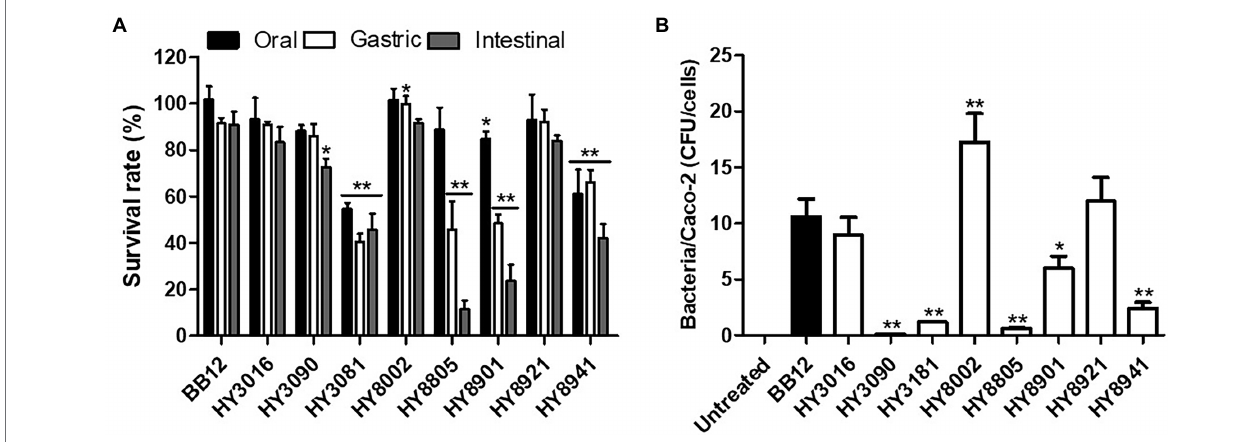
FIGURE 2 | (A) Survival rate of bifidobacterial strains in simulated gastrointestinal tract conditions. (B) The number of bacterial cells attached to one Caco-2 cell under co-culture conditions. “Bacteria/Caco-2 cells” indicates bacterial colony-forming units (CFU) per Caco-2 cell. Data are represented as mean ± SEM of three independent experiments. * p < 0.05 and ** p < 0.01 as compared with